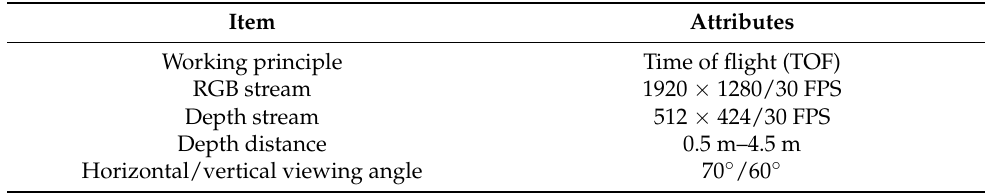
Table 1. Device parameters of Kinect V2 camera.